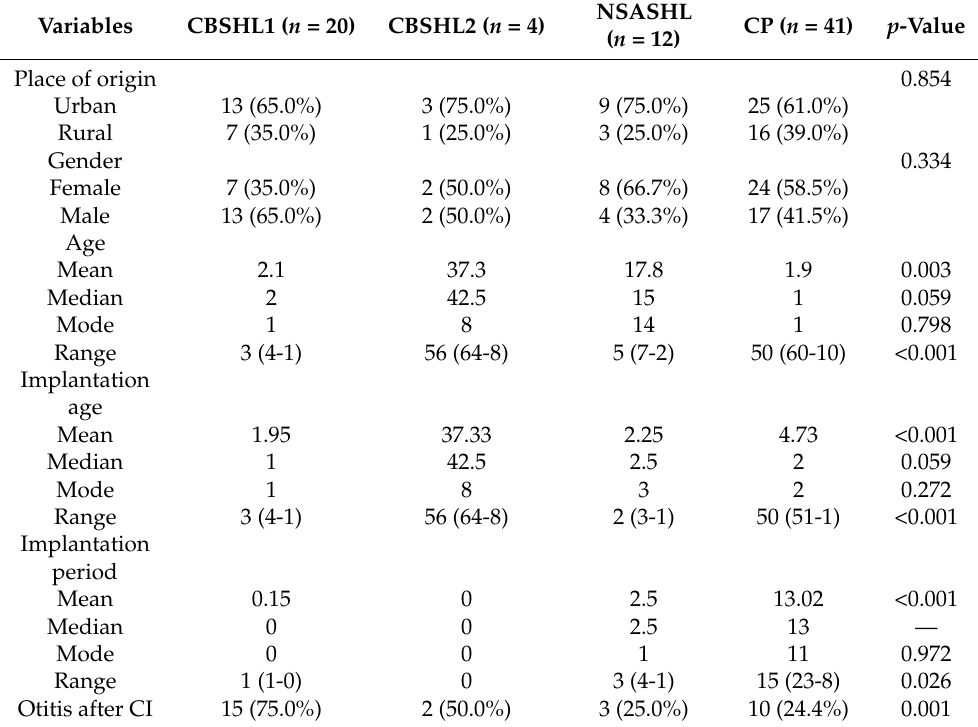
Table 1. General characteristics of the study